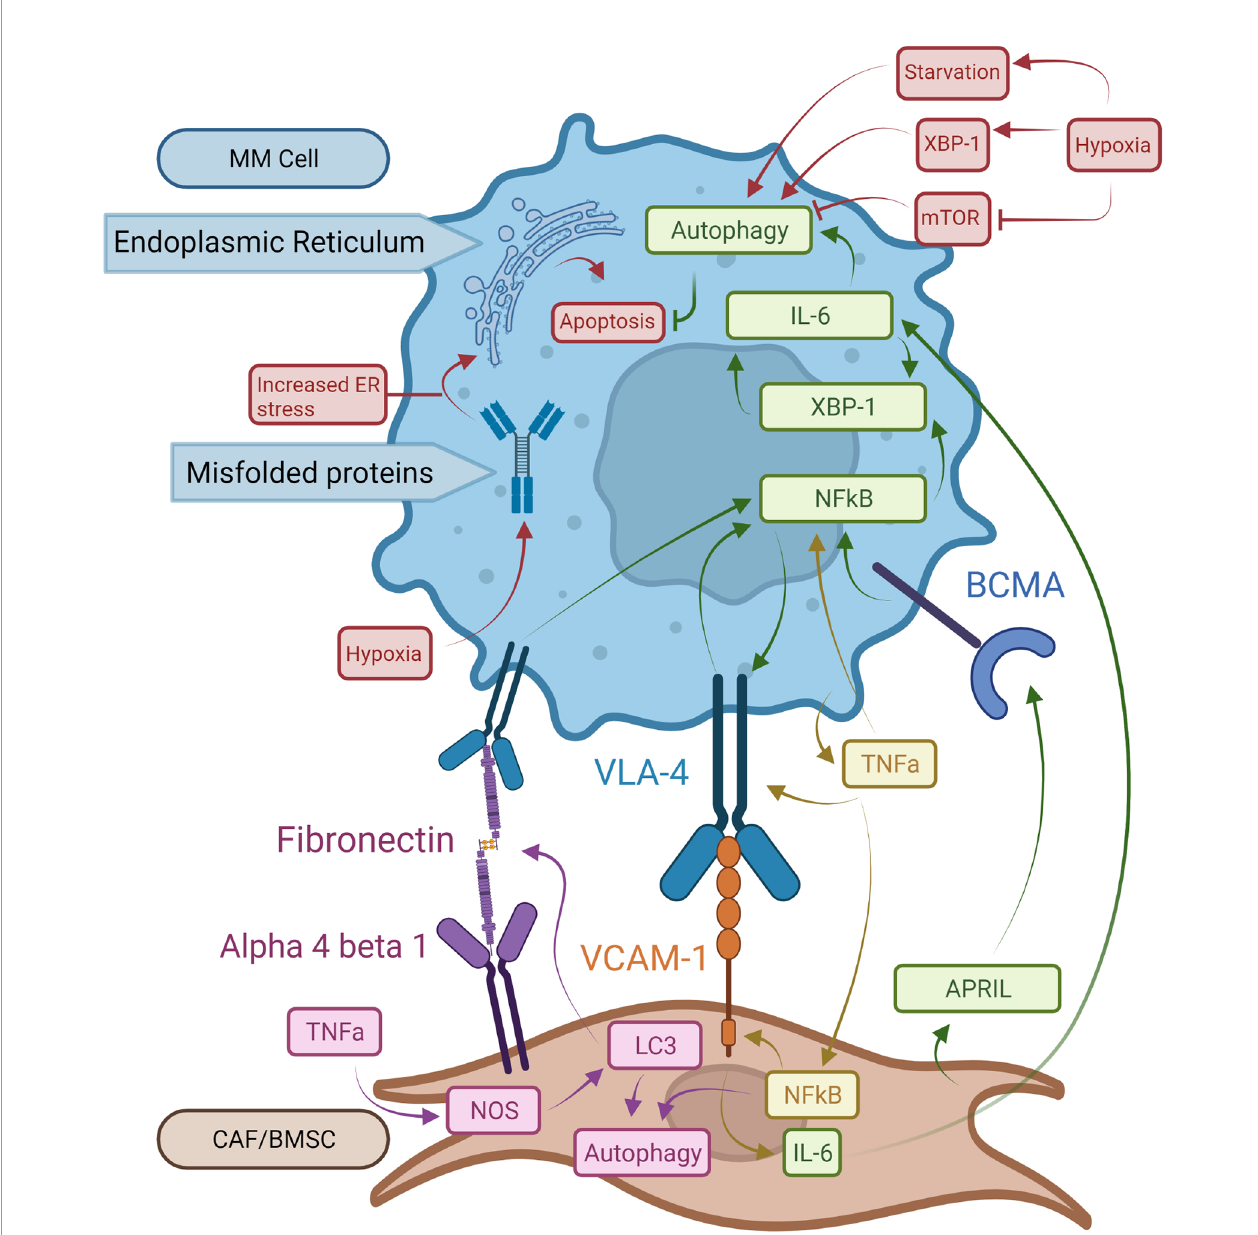
FIGURE 2 | Pro-oncogenic signaling mechanisms in MM cells and BM microenvironment structures. BCMA receptors activated by APRIL increase NF k B activity. This leads to XBP-1 upregulation with enhanced autophagy and expression of VLA-4 on MM cells. Binding of VLA-4 with VCAM-1 on BMSCs induces NFkB expression in MM cells resulting in a stimulatory feedback loop. Bound VCAM-1 in turn increases IL-6 synthesis in BMSCs which promotes autophagy and survival in MM cells. TNF-a made by MM cells increases NFkB expression in both MM cells and BMSCs and augments VLA-4 expression on MM cell surfaces. NFkB in BMSCs boosts expression of VCAM-1 enhancing binding to MM cells. In BMSCs, TNF- a induces autophagy via LC3, which also binds fi bronectin mRNA increasing fi bronectin expression in BMSCs. Extracellular fi bronectin protein can bind to VLA-4 on MM cells and enhance NFkB activity. Hypoxia exacerbates the UPR on the ER by driving autophagy via XBP-1 expression. Finally, mTOR works as a suppressor of autophagy, which is inhibited by